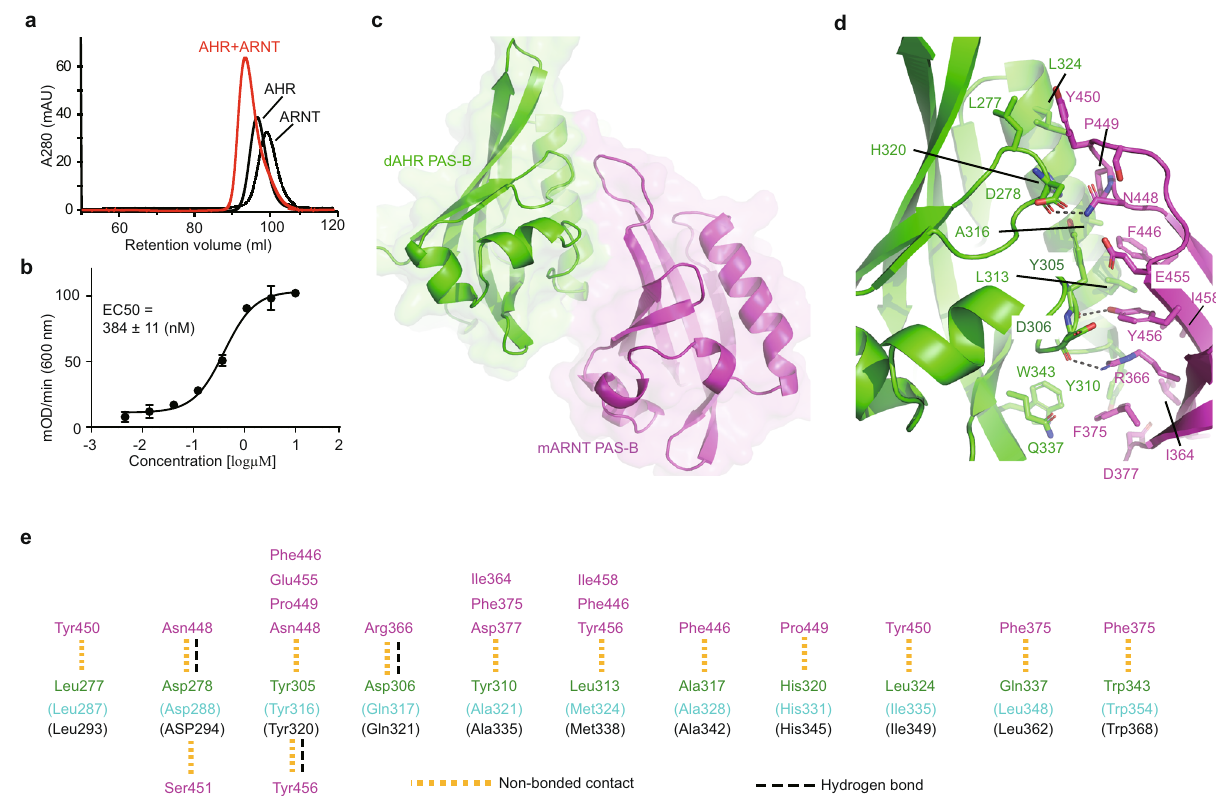
Fig. 4 | Structure of the dAHR PAS-B:mARNT heterodimer. a Evaluation of the interactionbetweendAHRPAS-BandmAHRPAS-BbySEC. b Thebindingaf fi nityof dAHRPAS-BtomARNTPAS-BmeasuredbyELISA.Theresultsrepresenttheaverage value of three independent experiments. Data are shown the mean±standard deviation of n =3 independent replicates. Source data are provided as a Source Data fi le. c The overall structure of the dAHR PAS-B:mARNT heterodimer. dAHR